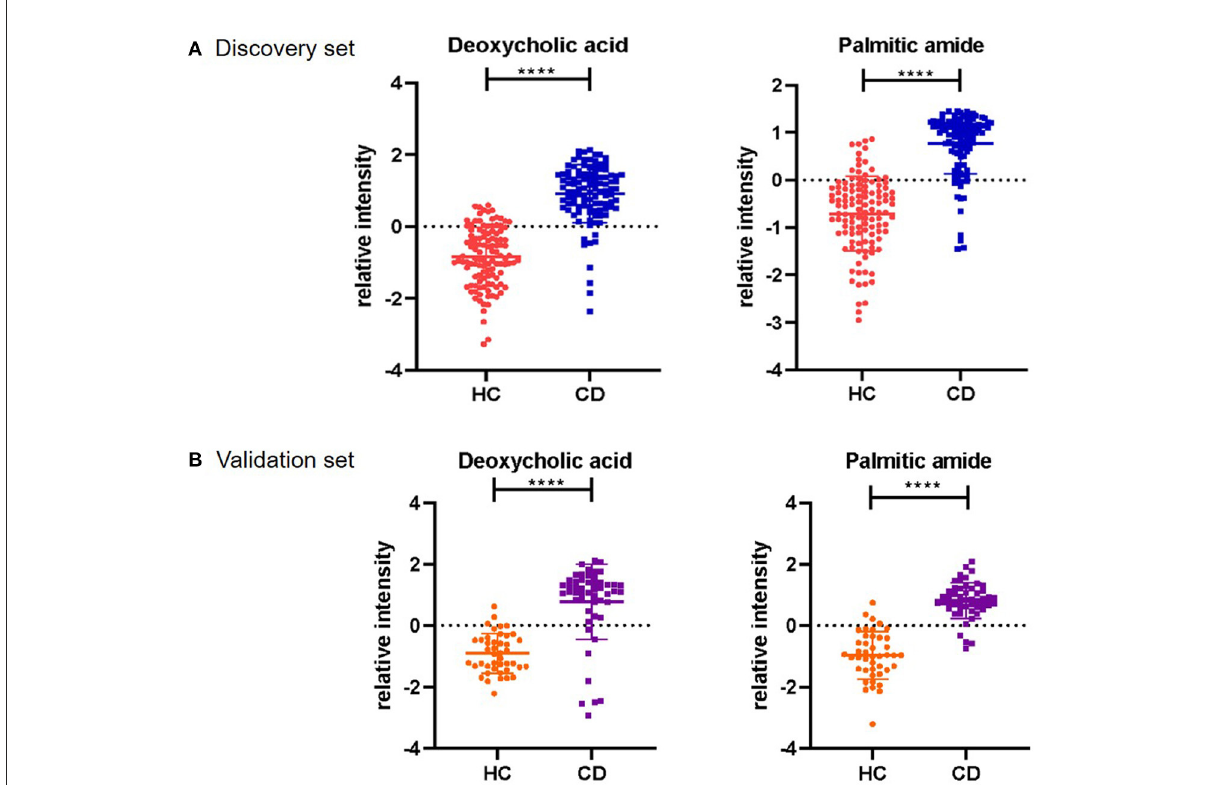
FIGURE5 Serum relative intensity of the defined potential biomarkers. Discrimination of CD patients and healthy individuals with the combination of two potential biomarkers. Serum relative intensities of Deoxycholic acid and Palmitic amide in the discovery set (A) and validation set (B) . Statistical differences are marked by an asterisk, **** P <